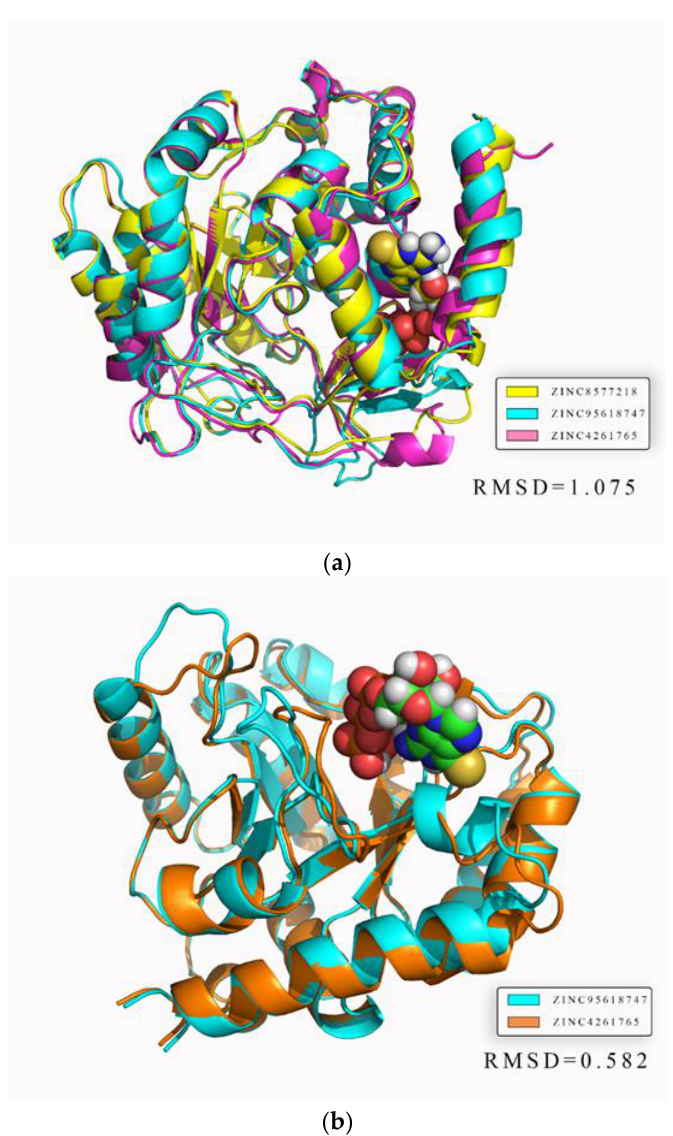
Figure 19. Average structure of each protein reacted with different ligands. The ligand is shown in the figure. ( a ) DHODH protein. ( b ) UMPS protein.